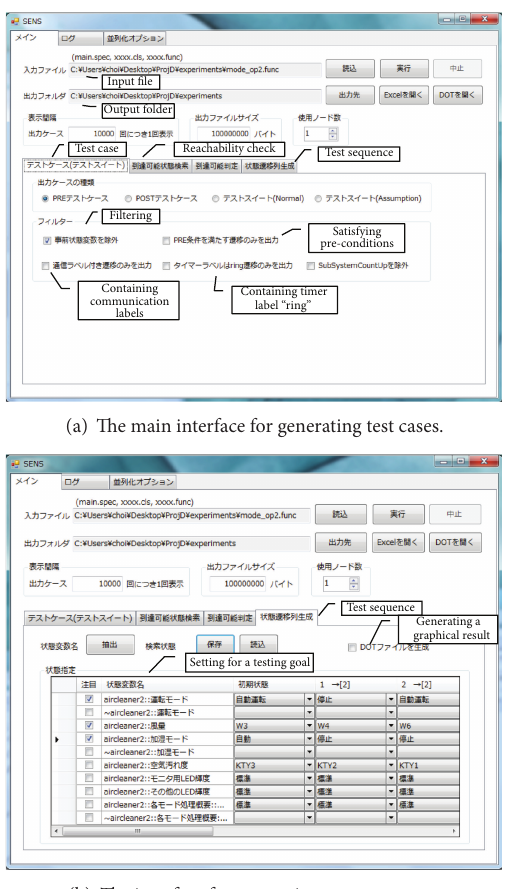
Figure 9: The GUI interface of TGSENS